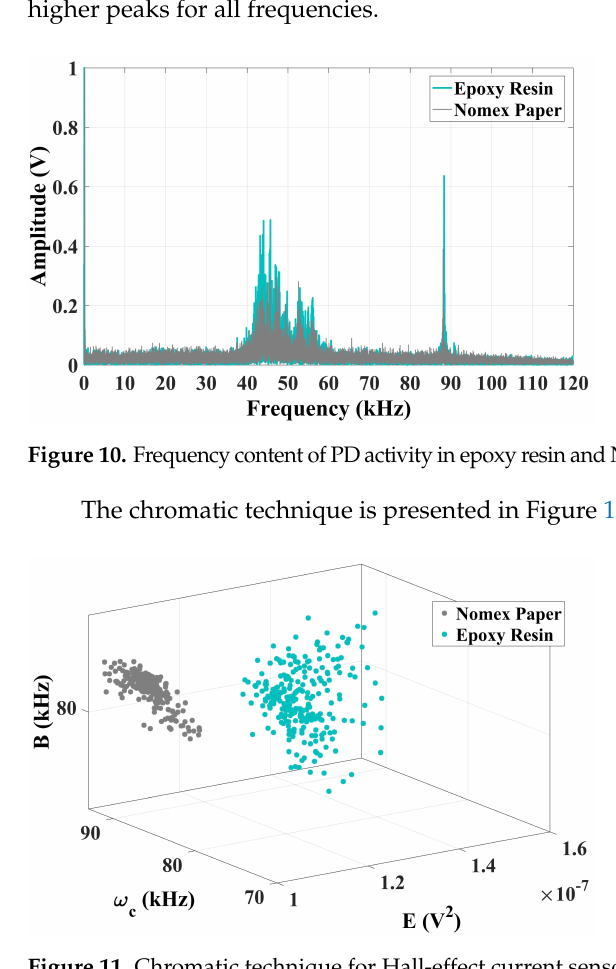
Figure 11. Chromatic technique for Hall-effect current